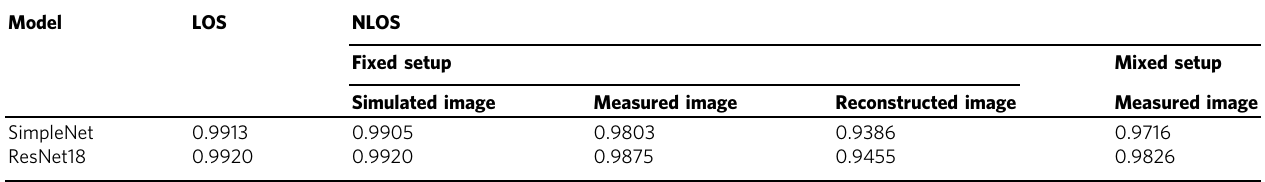
Table 1 Line-of-sight (LOS) and non-line-of-sight (NLOS) recognition accuracies with SimpleNet and ResNet18 in a dark room.